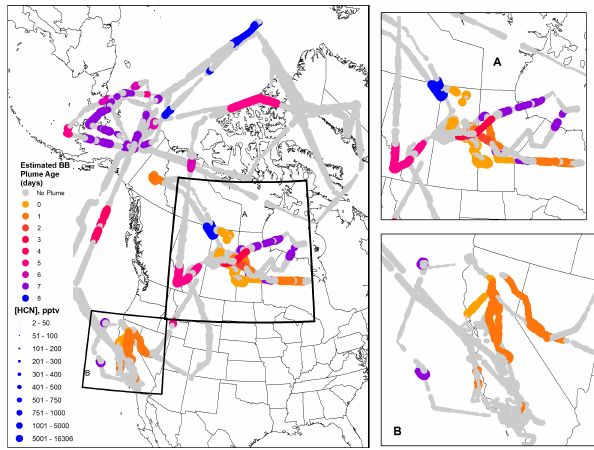
Fig. 5. Map of the plume interceptions on all the DC-8 flight paths during ARCTAS. Colored points indicate plume interceptions ac- cording to the upper legend, with estimated BB plume ages based on back trajectories, altitude, and location relative to local fires. Points are sized according to the reported HCN mixing ratio, as indicated in the lower legend. Detail map A is an expanded map showing the ARCTAS-B flights over central Canada, and detail map B is an ex- panded map showing the ARCTAS-CARB flights over